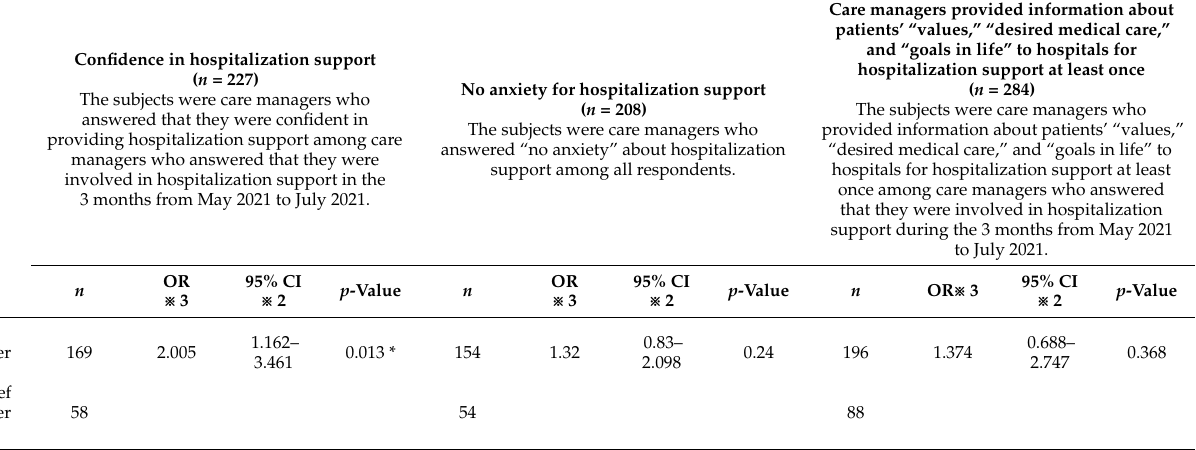
Table 7. Associations between the chief care manager certification status and hospitalization support practice, confidence, and